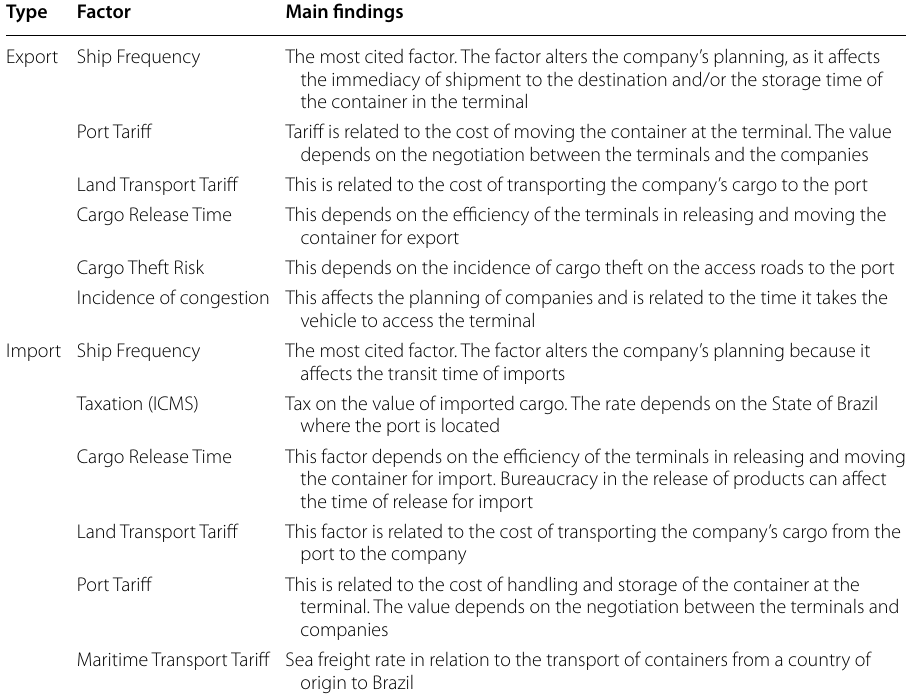
Table 4 Key findings about exporters and importers Type Factor Main